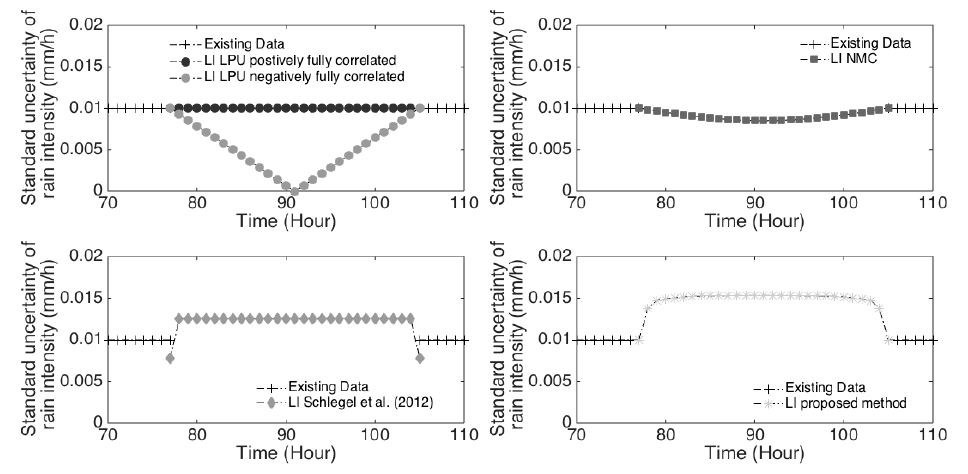
Figure 1. Different methods to asset prediction uncertainties.